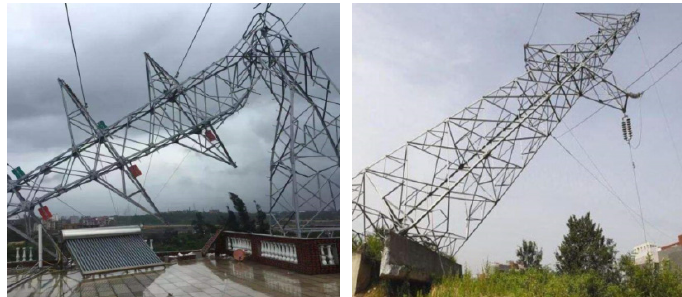
Figure 1. Tower collapse in typhoon weather.